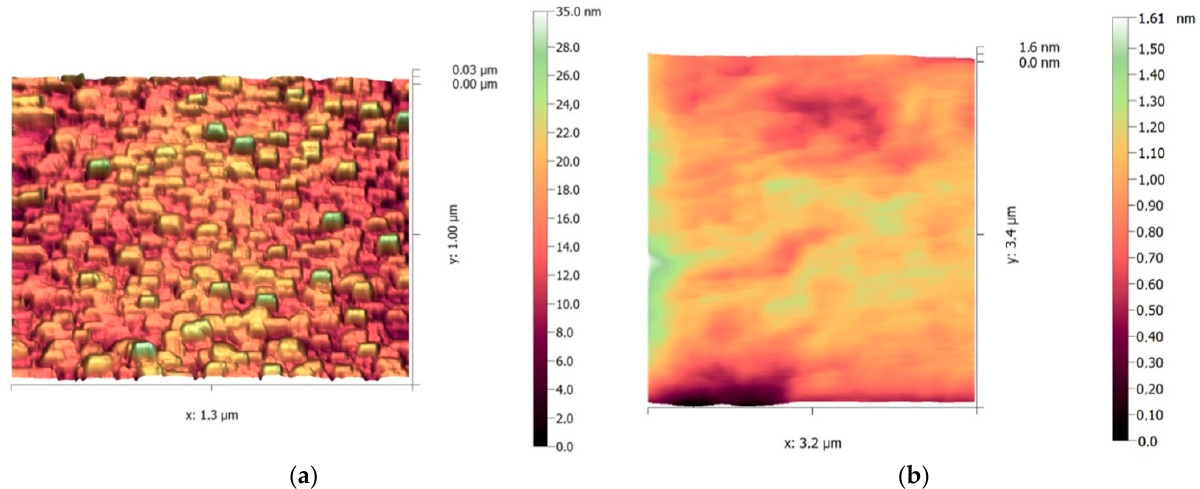
Figure 2. Images of the Au surface covered with AgI ( a ) and Ag ( b ) films obtained by an atomic force microscope.